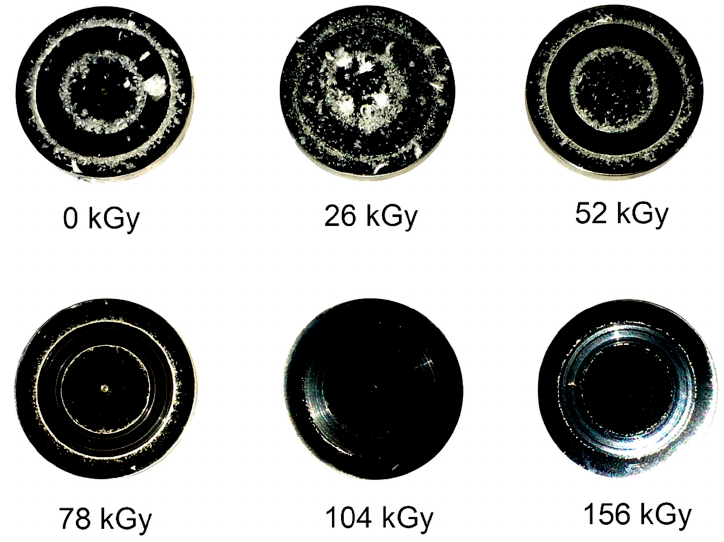
Figure 10. Images of 1H18N9T steel discs after tribological cooperation with pins made of PTFE in the initial state and after electron beam irradiation.